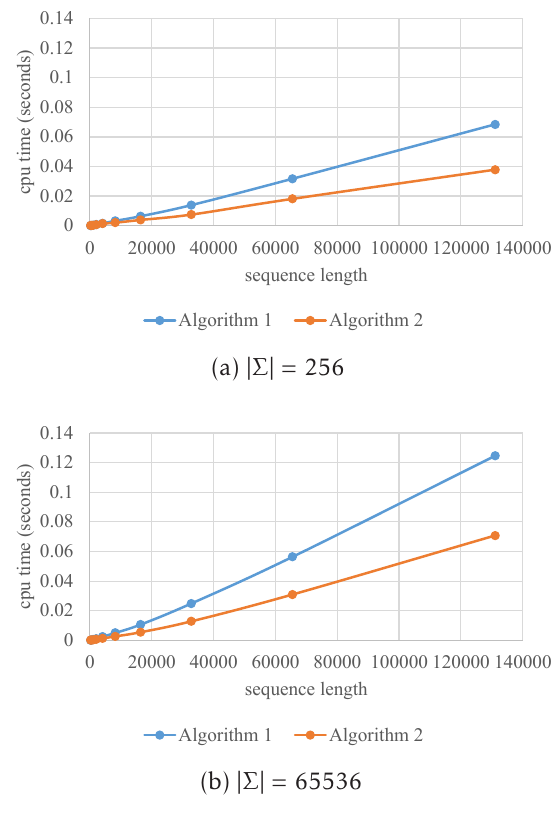
Figure 5. Average CPU time for sequences of 64-bit doubles from varying size